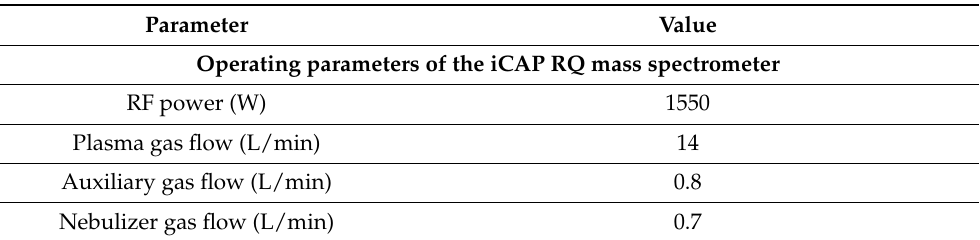
Table 2. Change in characteristics of TiO 2 NP size distributions of cosmetic product samples after background signal